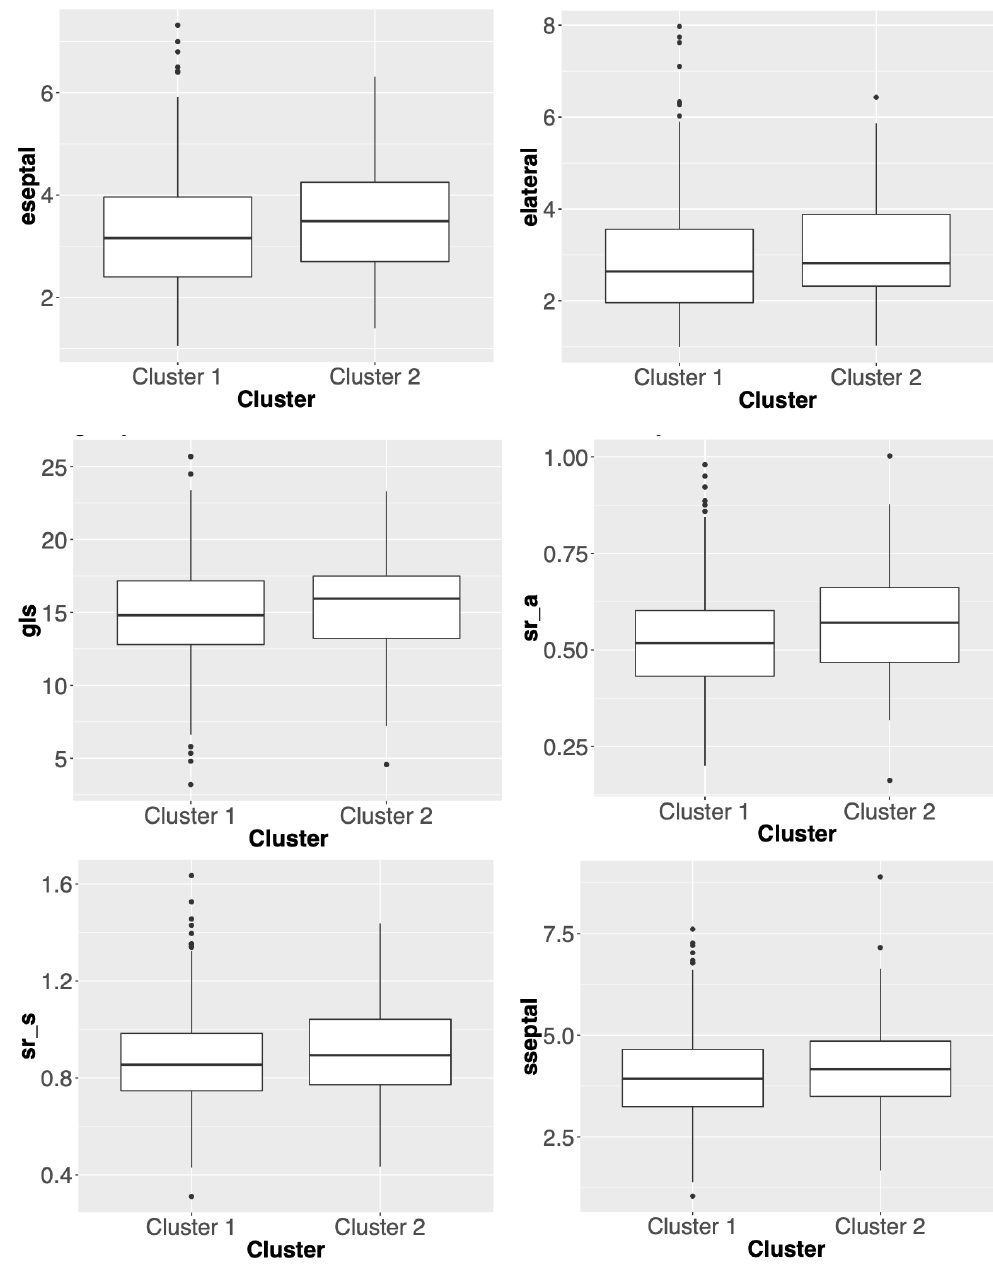
Figure 3. Box plots of phenotypic/outcome variables whose distributions are significantly different between two clusters in Caucasian cohort. The p -values for eseptal, elateral, gls, sr_a, sr_s and sseptal are 0.0135, 0.0465, 0.0246, 0.0151, 0.0774, 0.0879